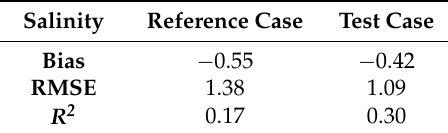
Table 2. Comparison of mean transect salinity from observations and corresponding values from model without (reference case) and with (test case) satellite-derived Kd and rainfall. Unit for bias and RMSE are ppt.